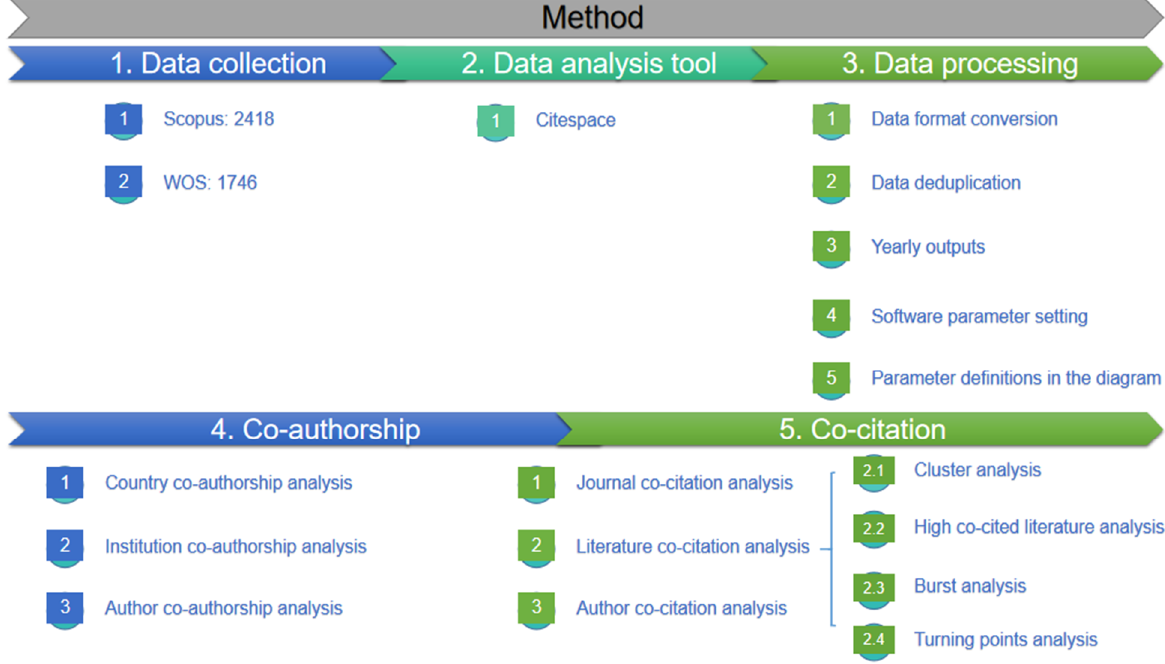
Figure 1. Research method flow